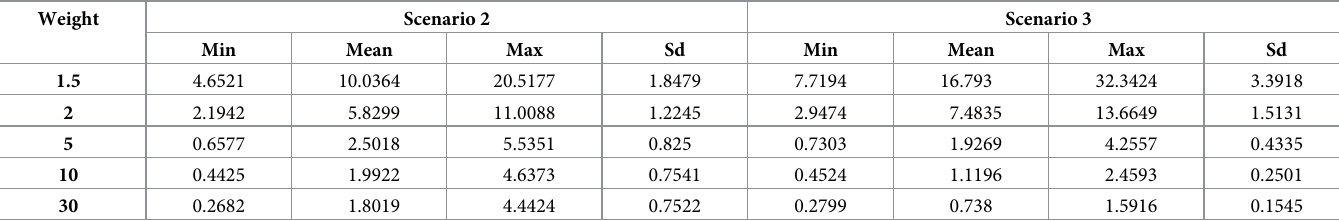
Table 2. Summary of the residual sum of